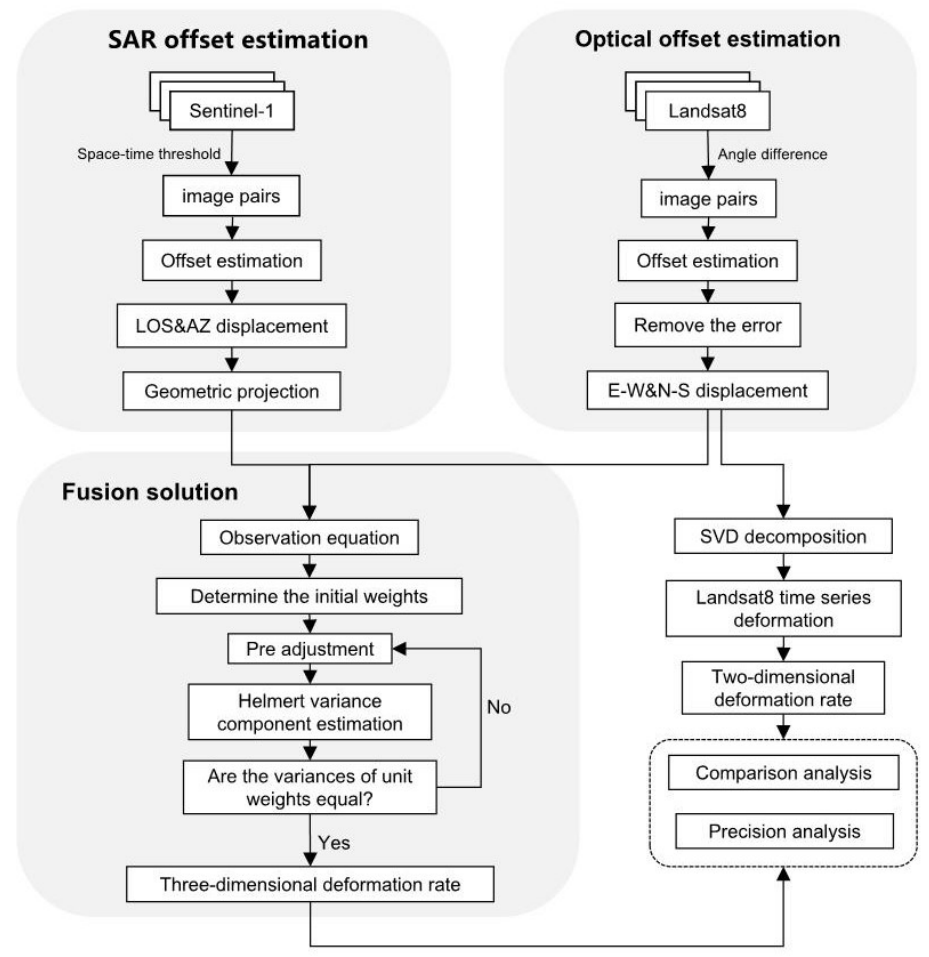
Figure 2. Technical flow chart of the data processing.